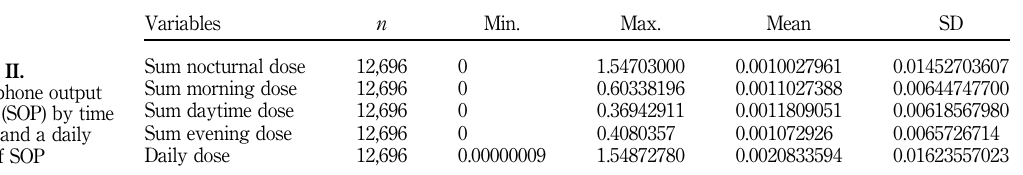
Table I. Time cycles headache of participants presented as a percent